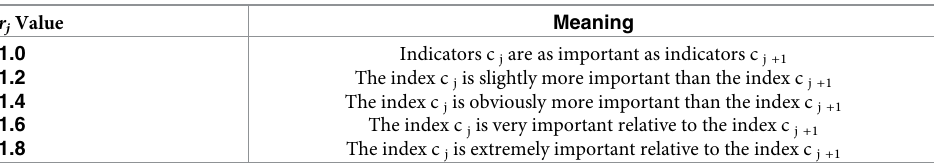
Table 3. The relative importance of a